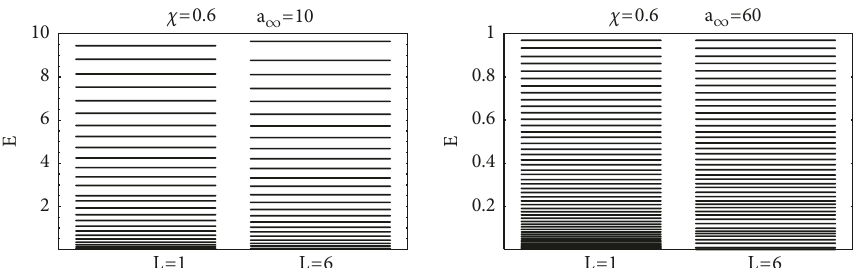
Figure 6: Energy spectrum 𝐸 for the linear dipole problem with boundary conditions on the volume from Eq. (47), or Eq. (54), for small dipole strength, 𝜒 = 0.6 . We present two cases of volume radii, 𝑅 = 𝑎 ∞ = 10,60 . The coupling of energy with angular momentum is reduced, so we notice a weak dependence of 𝐿 . For larger volumes the spectrum is richer, note the difference in scale of left and right frames.